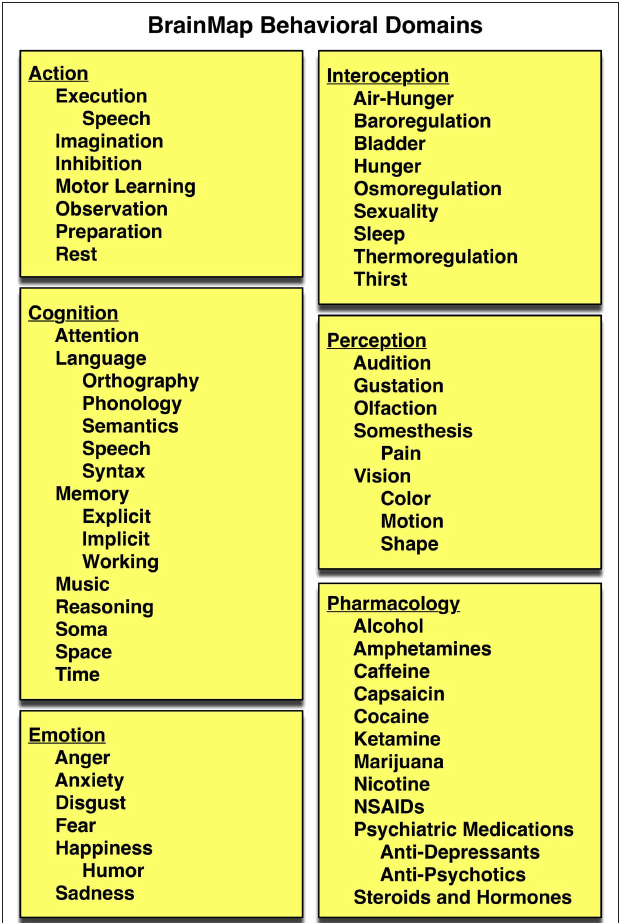
FIGURE 3 | BrainMap behavioral domains. In the BrainMap coding scheme, the behavioral domain is recorded for each statistical contrast, which describes the research in terms of the neural systems studied according to 6 main categories: cognition, action, perception, emotion, interoception, or pharmacology. The yellow background represents that this fi eld lies at the Experiment level.